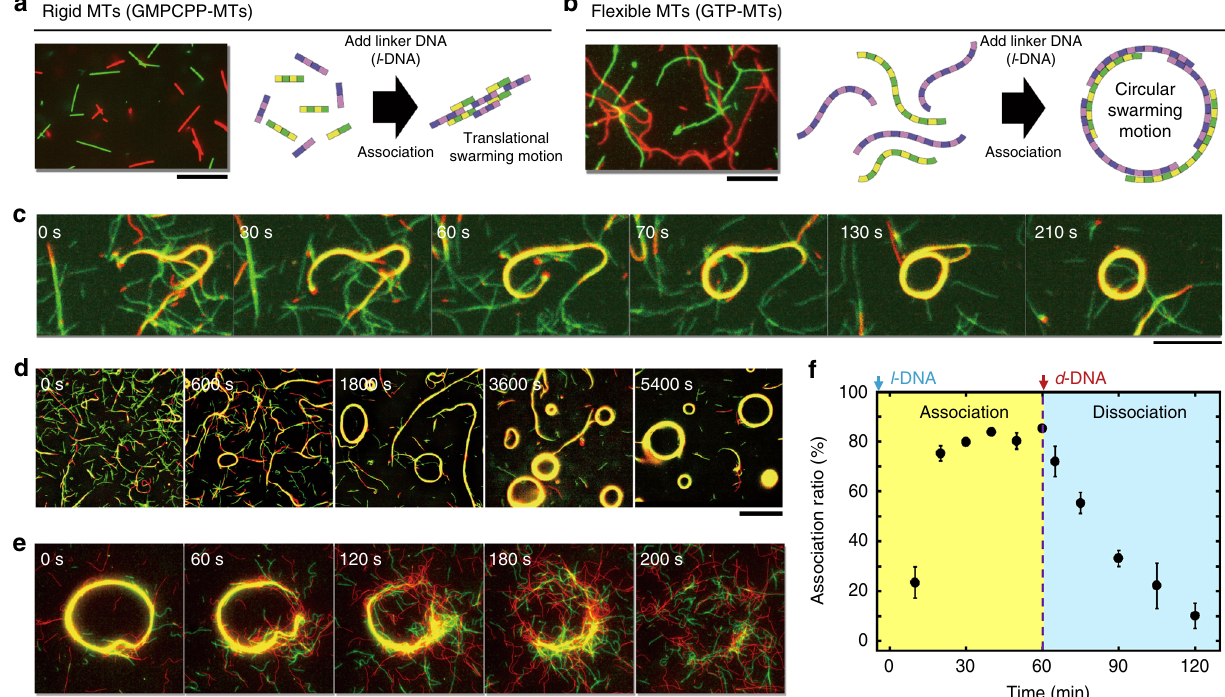
Fig. 3 Regulation of swarming mode of MTs by tuning their physical properties. a , b Fluorescence microscopy images of rigid and fl exible MTs, respectively; schematic illustrations showing different swarming modes of the MTs. c Time-lapse fl uorescence microscopy images showing the formation of a swarm group with a circular motion from fl exible red and green MTs with lengths of 22 ± 13 µ m and 16 ± 9 µ m (average ± s.d.), respectively. d Time-lapse fl uorescence microscopy images showing the formation of swarms with a circular motion in the presence of l -DNA1 (0.6 µ M). e Dissociation of a swarm group with a circular motion triggered by the d -DNA input signal (0.6 µ M). The swarm group was made of ~300 single MTs. f Change of the association ratio over time upon addition of l -DNA1 and d -DNA. The concentration of the red and green MTs was 0.6 µ M each, and the conjugation ratio of r -DNA1 or r -DNA2 to MTs was ~100%. The concentration of kinesin was 0.3 µ M. Scale bar: 20 µ m ( a – e ). Error bar: